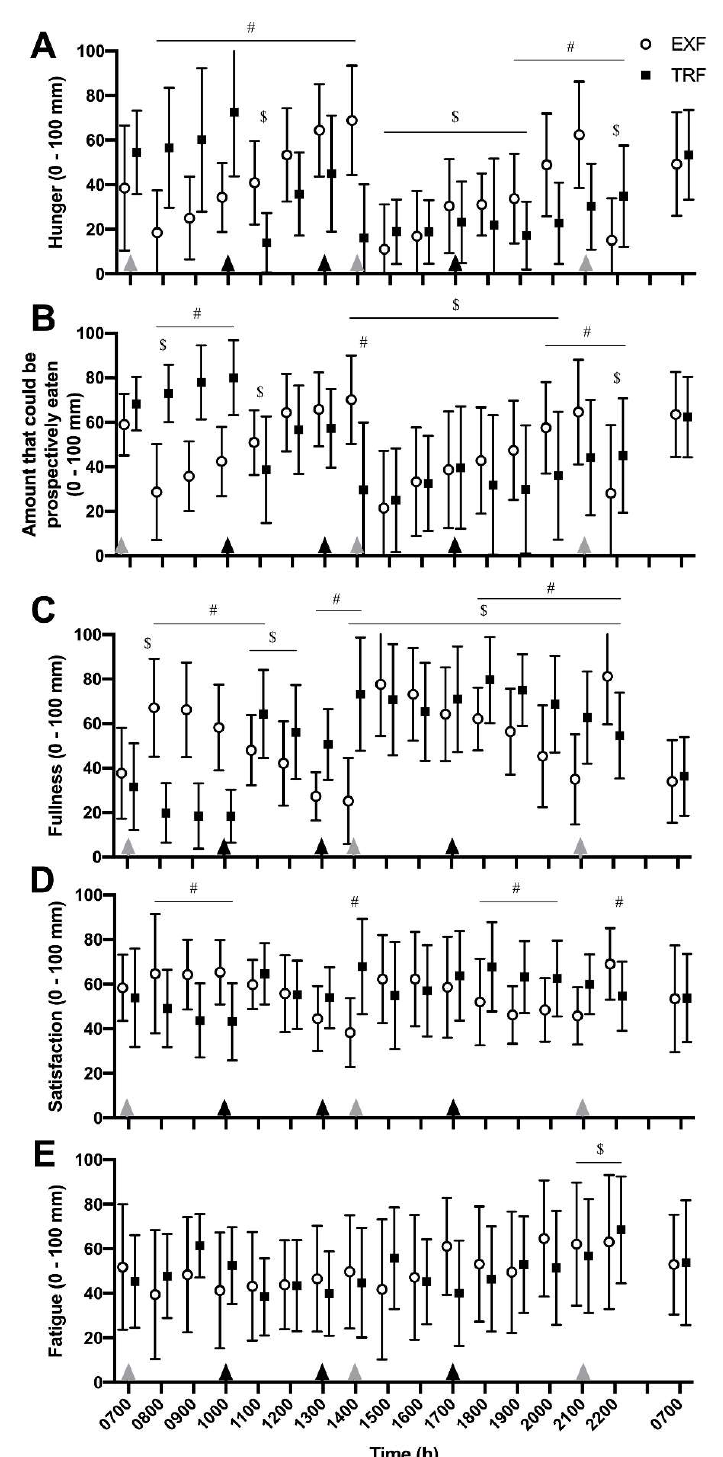
Figure 6. Subjective hunger ( A ), appetite ( B ), fullness ( C ), satiety ( D ) and fatigue ( E ) responses to visual analogue scale questions (0–100 mm) from participants with overweight / obesity (n = 11) throughout trial conditions of time-restricted feeding (TRF; black bars) and extended feeding (EXF; white bars). Black triangles represent TRF mealtimes whereas grey triangles represent EXF mealtimes. Data are mean ± SD. p < 0.05 for # significantly di ff erent between conditions within time point; $ significantly di ff erent to baseline (0700 h; e ff ect of